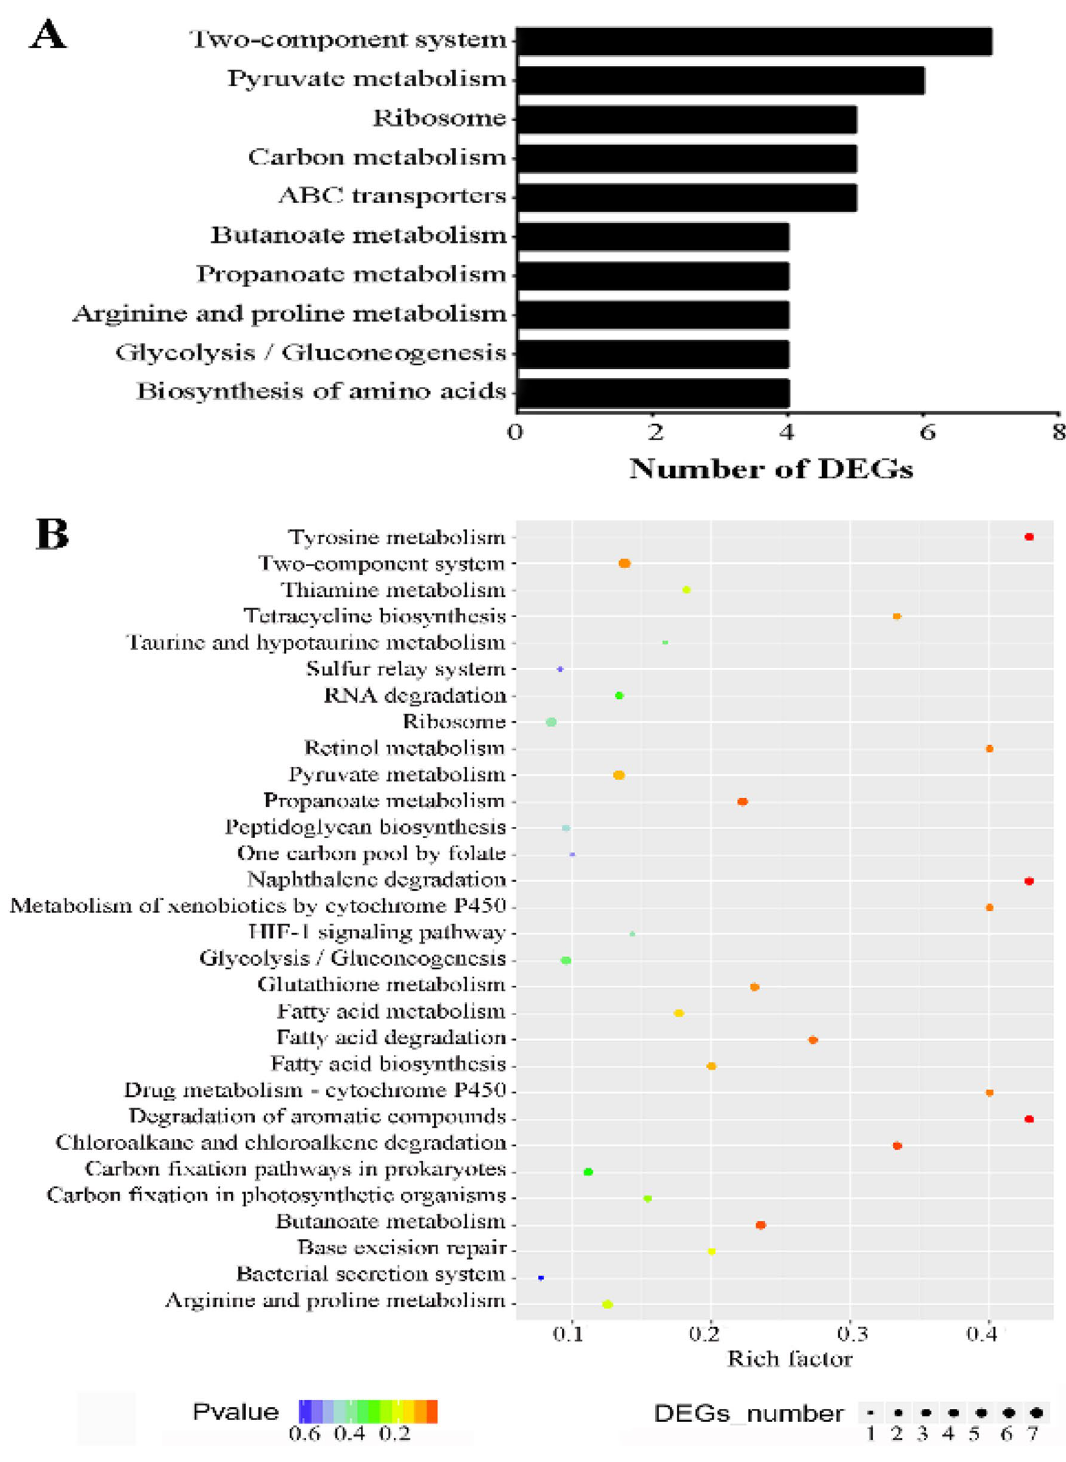
Figure 6. Kyoto Encyclopedia of Genes and Genomes (KEGG) pathway enrichment analysis of 281 differentially expressed genes. ( A ) The top 10 pathways were identified according to the number of enriched genes. The pathway of two-component system had the greatest number of genes, followed by the pyruvate metabolism pathway. ( B ) The top 30 (558) pathways were identified according to the p value, rich factor, and the number of enriched